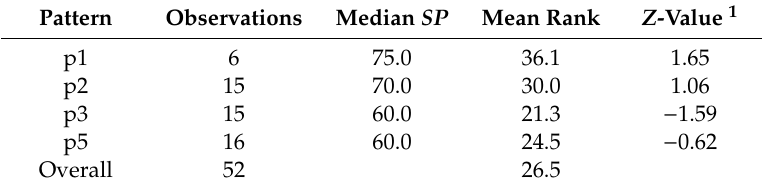
Table 2. Results of K-W test on patterns vs. use of three or four points of control.